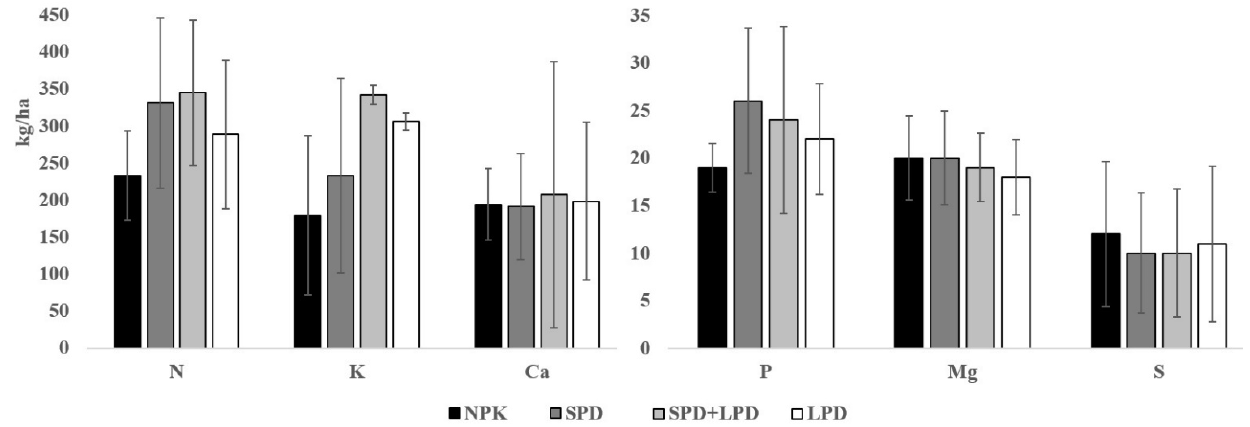
Figure 2. The average total uptake of cannabis macronutrients of individual experimental variants.